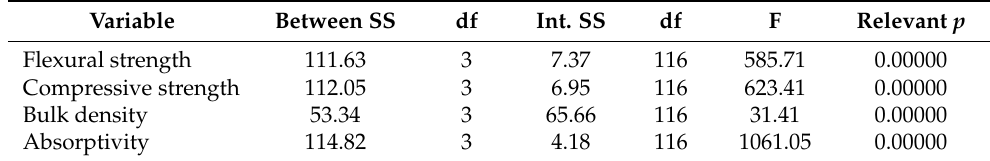
Table 11. Results of the analysis of variance.